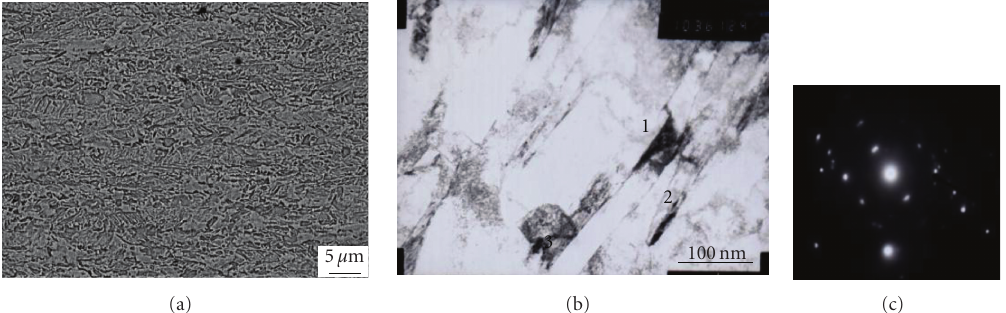
Figure 2: SEM and TEM pictures of grade X100 pipelines of metallurgical structure (a) and (b) and di ff raction pattern of ferrite and M/A constitute (c).